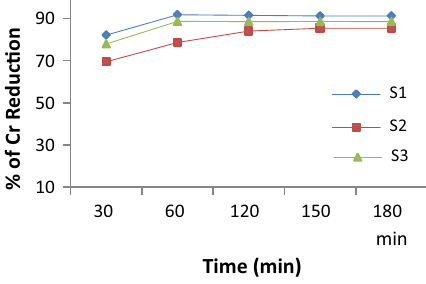
Fig. 5 Effect of contact time on % removal of Cr by tea waste adsor-